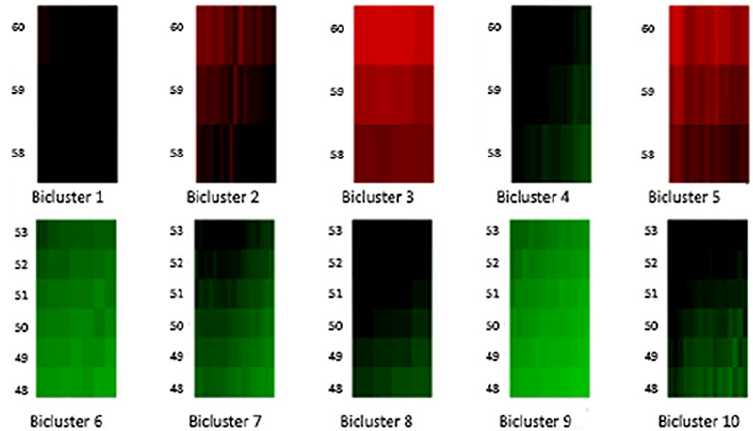
Figure 4. Biclusters 1–10.